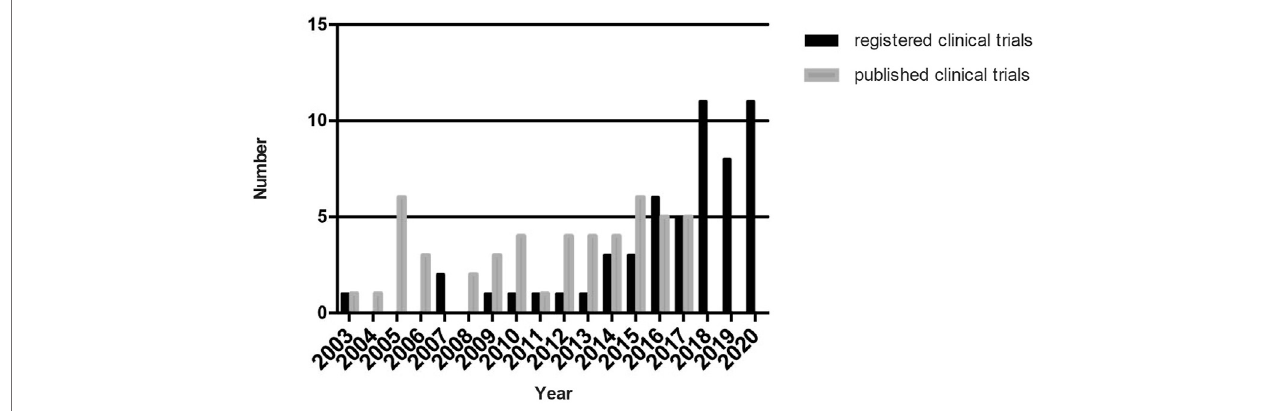
FIGURE 2 | Number of registered and published Raman spectroscopy clinical trials from 2003 to